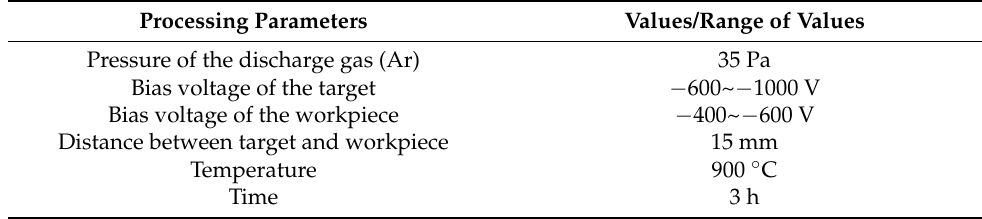
Figure 1. Schematic diagram of the plasma surface alloying technique. Table 2. Detailed processing parameters of Mo-surface-modified